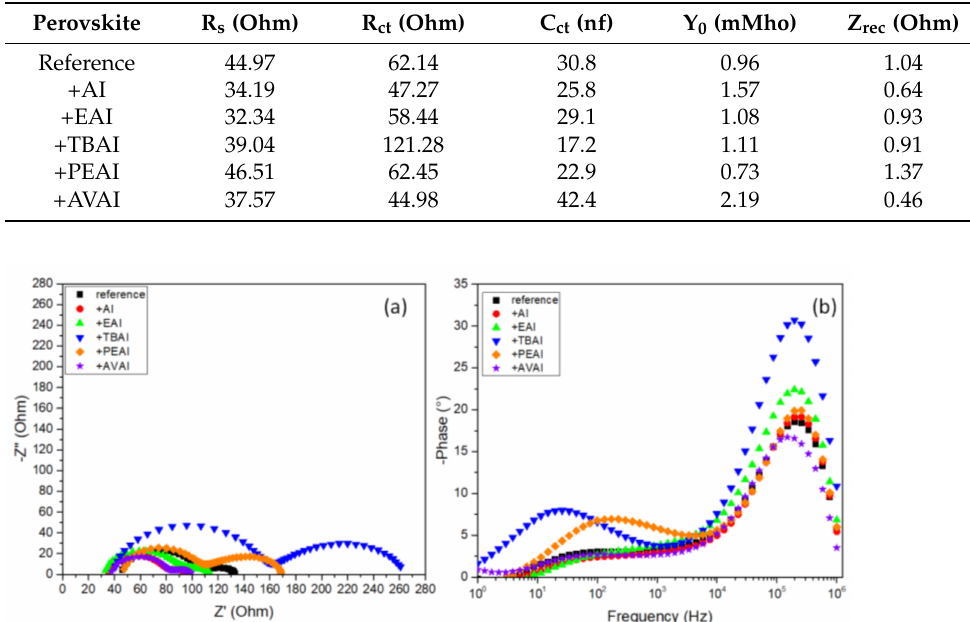
Table 3. The electrical parameters obtained after fitting of the experimental data of the as-prepared devices’ Nyquist plots.